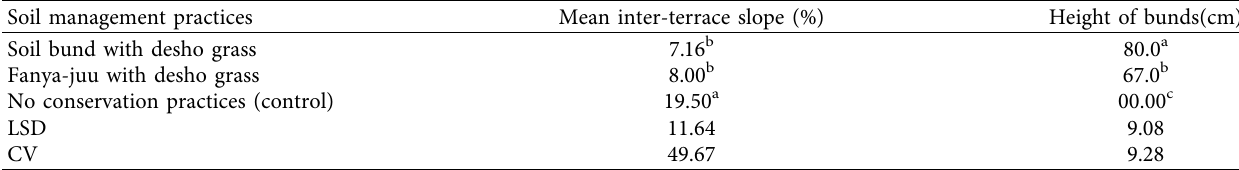
Table 5: Effect of soil management practices on inter-terrace slope of the study watershed. Soil management